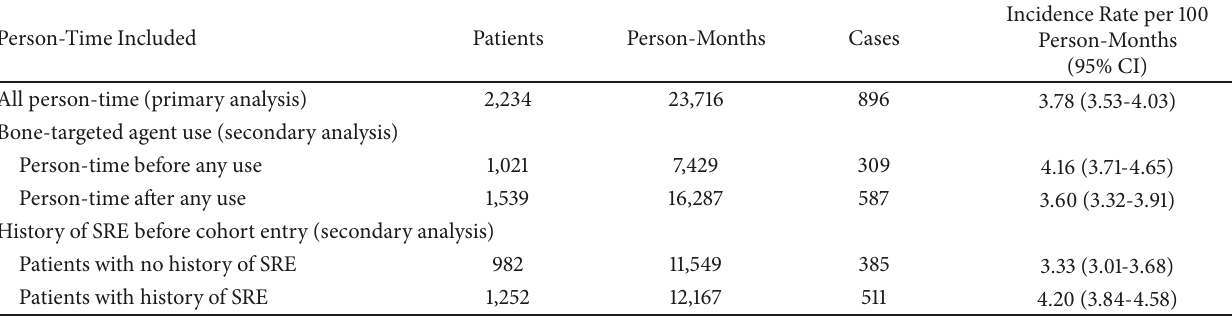
Table 4: Incidence rates of SREs among all person-time and stratified by initial bone-targeted agent use and history of SRE before cohort entry.